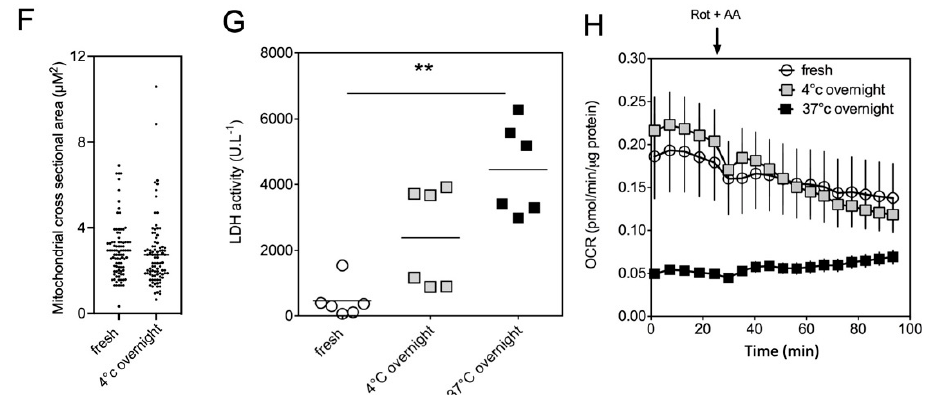
Figure 2. Oxygen (O 2 ) consumption measurements and the effect of conservation conditions in cardiac left ventricle samples. O 2 concentration (mmHg) ( A ), oxygen consumption rate (OCR, pmol/min/µg protein) ( B ) and mitochondrial OCR (%) ( C ) were quantified in cardiac left ventricle samples. In A , background (black line) corresponded to empty wells. A mix of rotenone (rot) and antimycin A (AA) was injected at the indicated time (arrow) in order to progressively inhibit mitochondrial respiration (red) and was compared to vehicle injection (grey). OCR had been assessed from duplicate biopsies of three mice for each condition ( n = 6) ( B ). Mitochondrial O 2 consumption was calculated from basal OCR (obtained without inhibitor, grey) subtracted to OCR level after rot/AA treatment (non-mitochondrial respiration, black). Both values were compared as a percentage of basal OCR for tissue samples and the cardiac cell line H9c2 ( C ). Representative histological sections (Hematoxylin-Eosin-Saffron staining) of fresh and conserved overnight at 4 °C and 37 °C heart samples ( D ). The corresponding macroscopically views were inserted in each panel. ( E ) Representative electronic microscopy images of heart (×20,000 magnification, scale bar: 2 µm) (S: Sarcomeres, M: Mitochondria); ( F ) Quantification of mitochondrial size (cross-sectional area). Approximately 100 mitochondria from four different hearts or lungs were analyzed. ( G ) Lactate dehydrogenase (LDH) activity (U.L-1) was quantified in the medium surrounding the heart ( n = 3) as a surrogate of potential tissue damage. Graphs showed the individual and mean values. Significant p values are indicated, ** p <0.001. ( H ) Quantification of OCR (pmol/min/µg protein) in cardiac left ventricles samples stored in the different conditions: fresh (white), 4 °C overnight (grey) and 37 °C overnight (black). OCR had been assessed from duplicate biopsies of three mice for each condition ( n = 6). Injection of rotenone (rot) and antimycin A (AA) was indicated by an arrow.